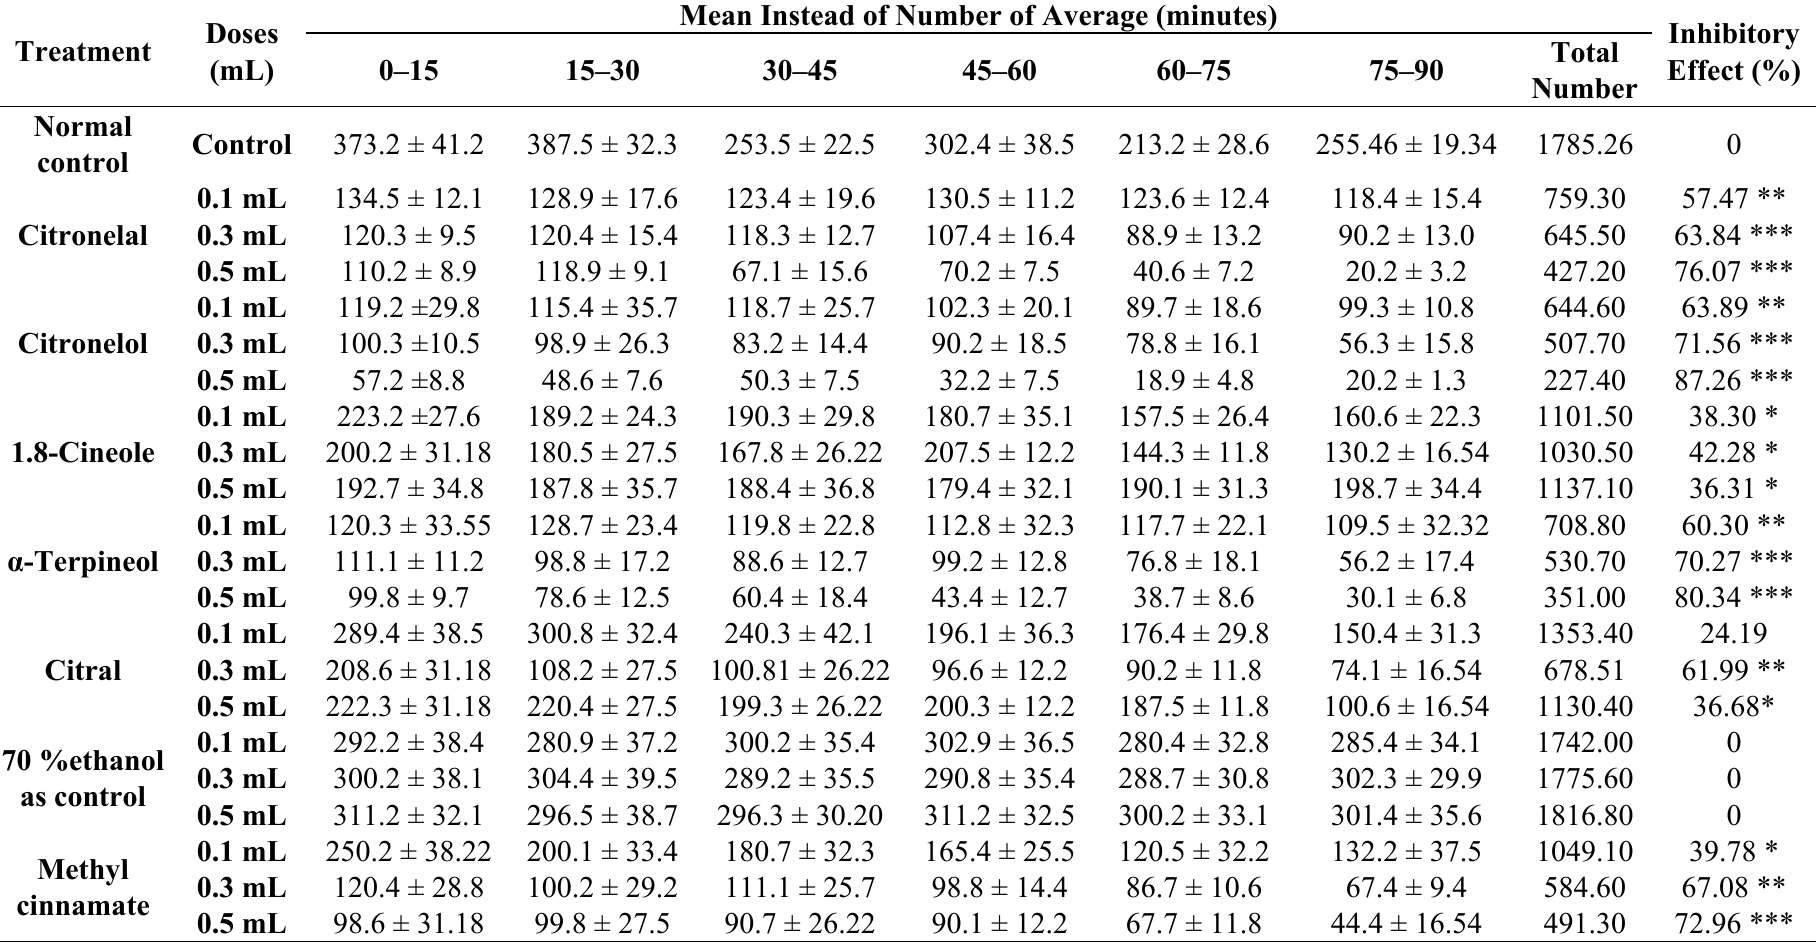
Table 6. The Average number of mice wheel cage rotations within 75 min of inhalation of f volatile compounds detected.